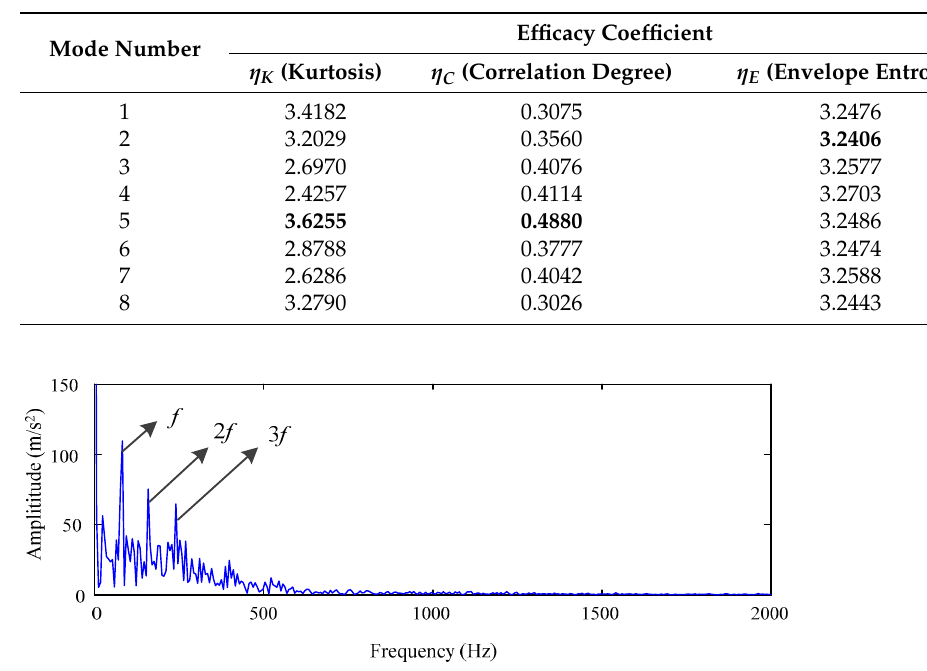
Figure 13. Envelope spectrum of optimal component by using VMD. Figure 14. Changing curve of between the value of the objective function and the iteration number. Table 1. Efficacy coefficients corresponding to Decomposed Mode components for simulation signal.